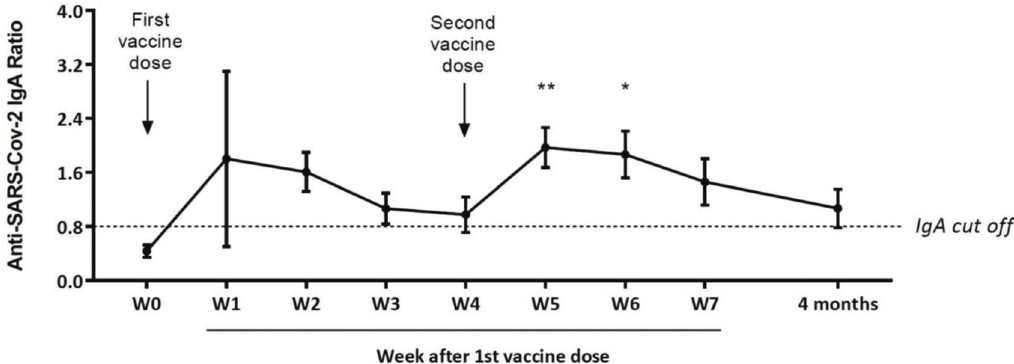
Figure 1 - Anti-SARS-CoV-2-specific IgA ratios (mean ± standard error) in milk samples collected over time (Weekly–W) from 16 healthy mothers previously COVID-negative after a 2-dose schedule of the CoronaVac vaccine (Sinovac Biotech Ltd., China). The last withdrawal was performed four months after the first dose in ten mothers. ** p o 0.01; * p o